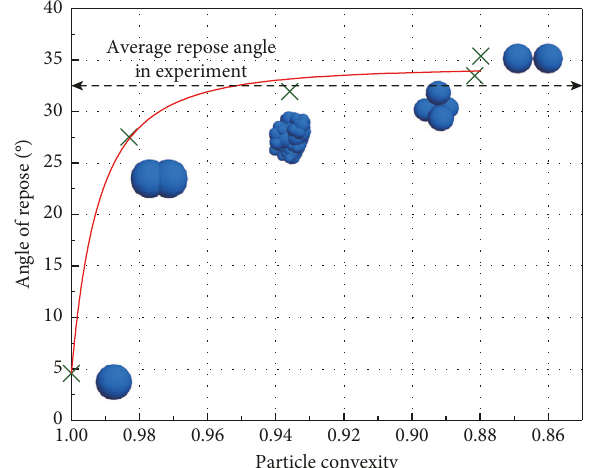
Figure 14: The effect of particle convexity on the angle of